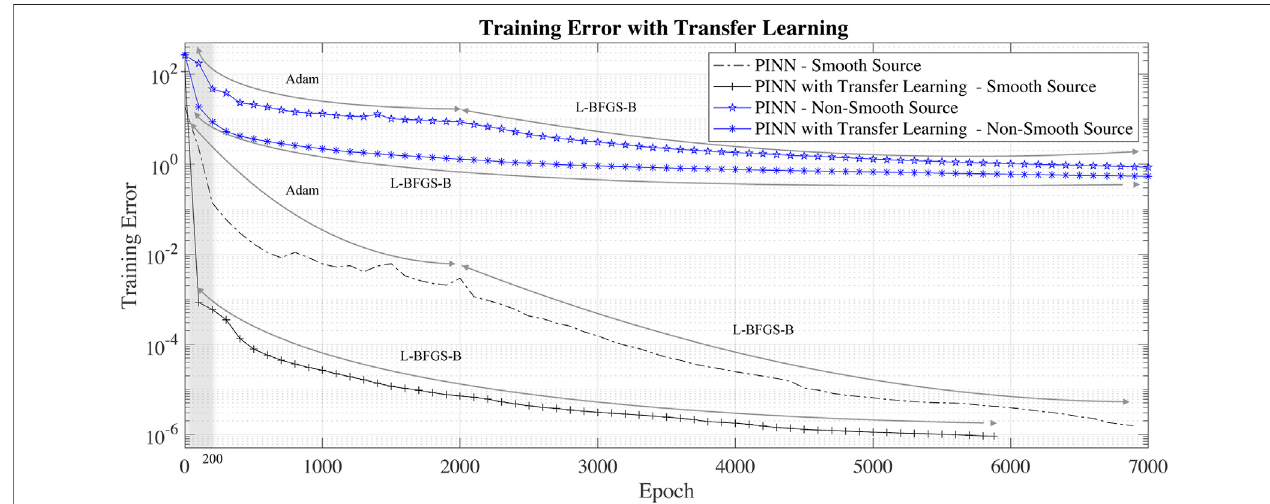
FIGURE 6 | Training error with and without transfer learning for the smooth and non-smooth source test cases.